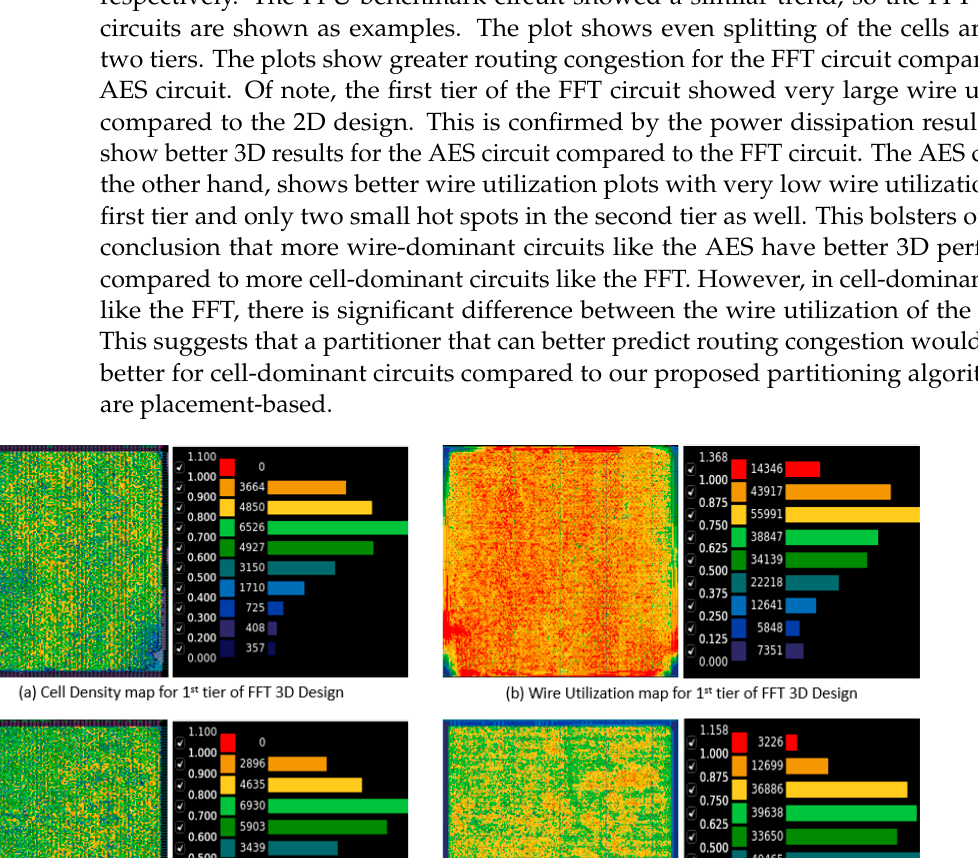
Figure 14. Cell density and wire utilization plots for two-tier AES 3D designs using the AQ partitioner. The timing analysis data for the 2D and two-tier 3D designs of the AES benchmark circuit are shown in Table 3. Four different corner configurations were considered in the design. They are fast-fast at 125 °C, fast-fast at − 40 ° C, slow-slow at 125 ° C, and slow- slow at − 40 ° C. The critical path length, slack, and clock period for the different corners are given in Table 3 along with the number of violating paths and the total negative slack for the 2D and two-tier 3D AES circuits. The timing violation statistics for the AES 2D and two-tier 3D designs are shown in Table 4. Both the 2D and 3D designs showed negligible violating nets compared to the total number of nets. The data shows similar timing per- formance for the 2D and the 3D circuits, so both the 2D and the two-tier 3D designs could be realized at a similar frequency.